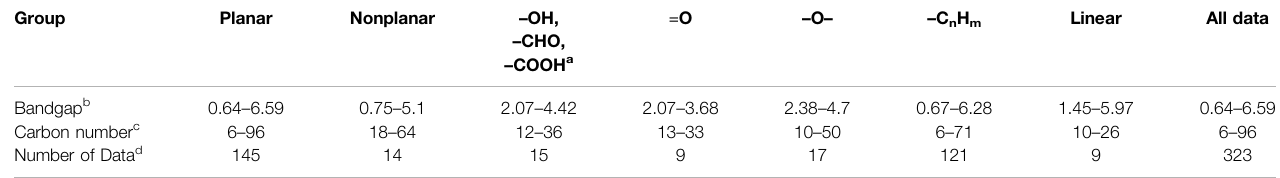
TABLE 1 | Key statistics of PAHs in different groups. Group Planar